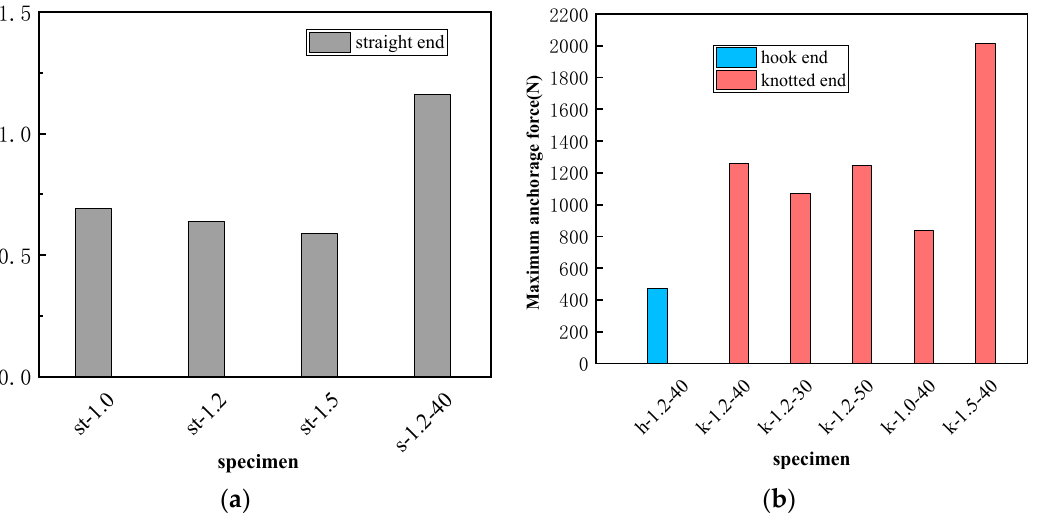
Figure 11. The comparison figure of the calculation parameters of test specimens. ( a ) Bond strength of SMA fibers with straight end; ( b ) Maximum anchorage force of SMA fibers with hook and knotted end.